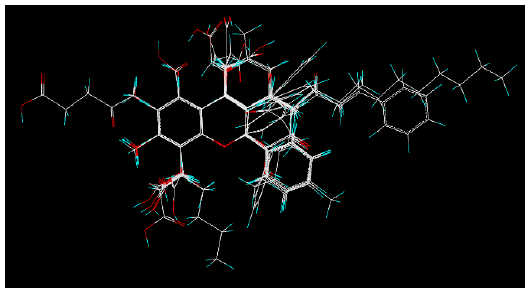
Figure 4. Alignment of all compounds in the training and test sets. Compound 3 was selected as the template for the alignment study, and the atoms of this compound were shown by different colors (C in white, H in cyan, and O in red).